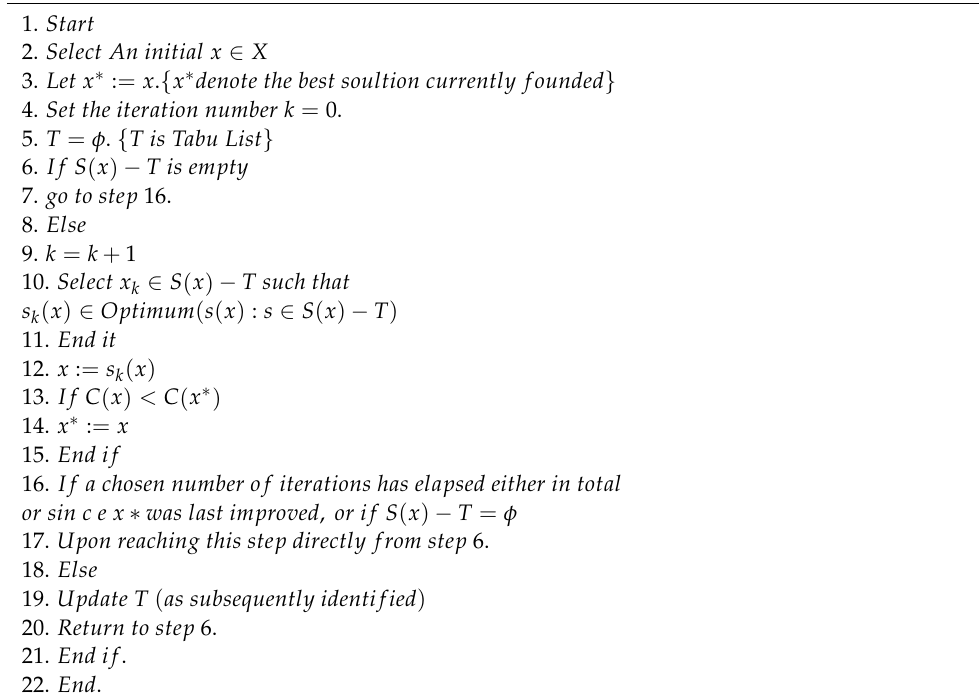
Algorithm 1 TS protocol’s